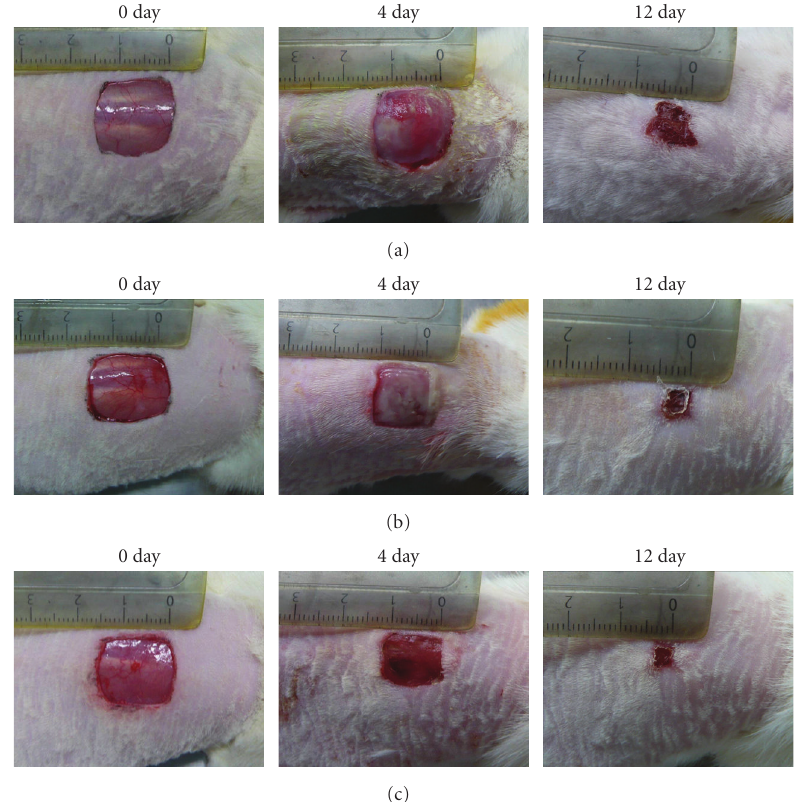
Figure 6: Photographs of macroscopic appearance of wound repair covered with (a) cotton gauze as control, (b) C2A2 without curcumin, and (c) C2A2 with curcumin, at day 0, day 4, and day 12, respectively.